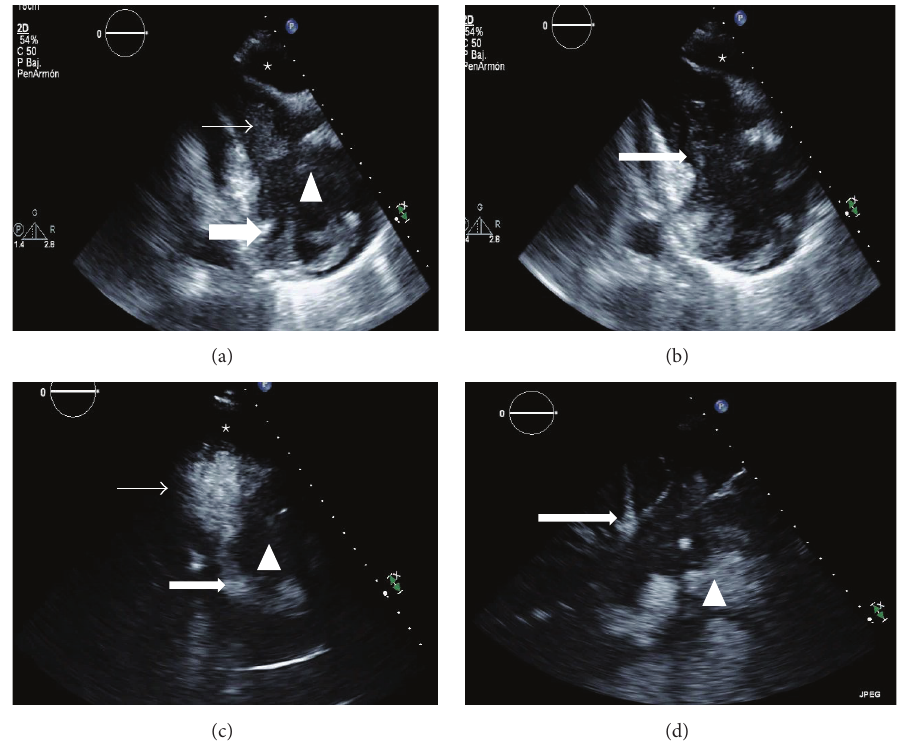
Figure 1: Transthoracic echocardiography with SonoVue (cid:2) contrast enhancement: (a) shows a homogeneous mass (arrowhead) in the right atrium (RA, thick arrow) which hindered blood flow to the right ventricle (RV, thin arrow), containing contrast medium. Pericardial effusion (star). (b) Same plane image showing stenosis at the tricuspid valve (arrow), with some contrast passing to the RV, as well as tricuspid stenosis. Pericardial effusion (star). (d) Echocardiogram showing contrast in most of the RV (thin arrow) and RA (thick arrow). The arrowhead refers to the homogeneous atrial mass. Pericardial effusion (star). (e) Subcostal plane, showing the contrast (arrowhead) and reflux into the suprahepatic veins